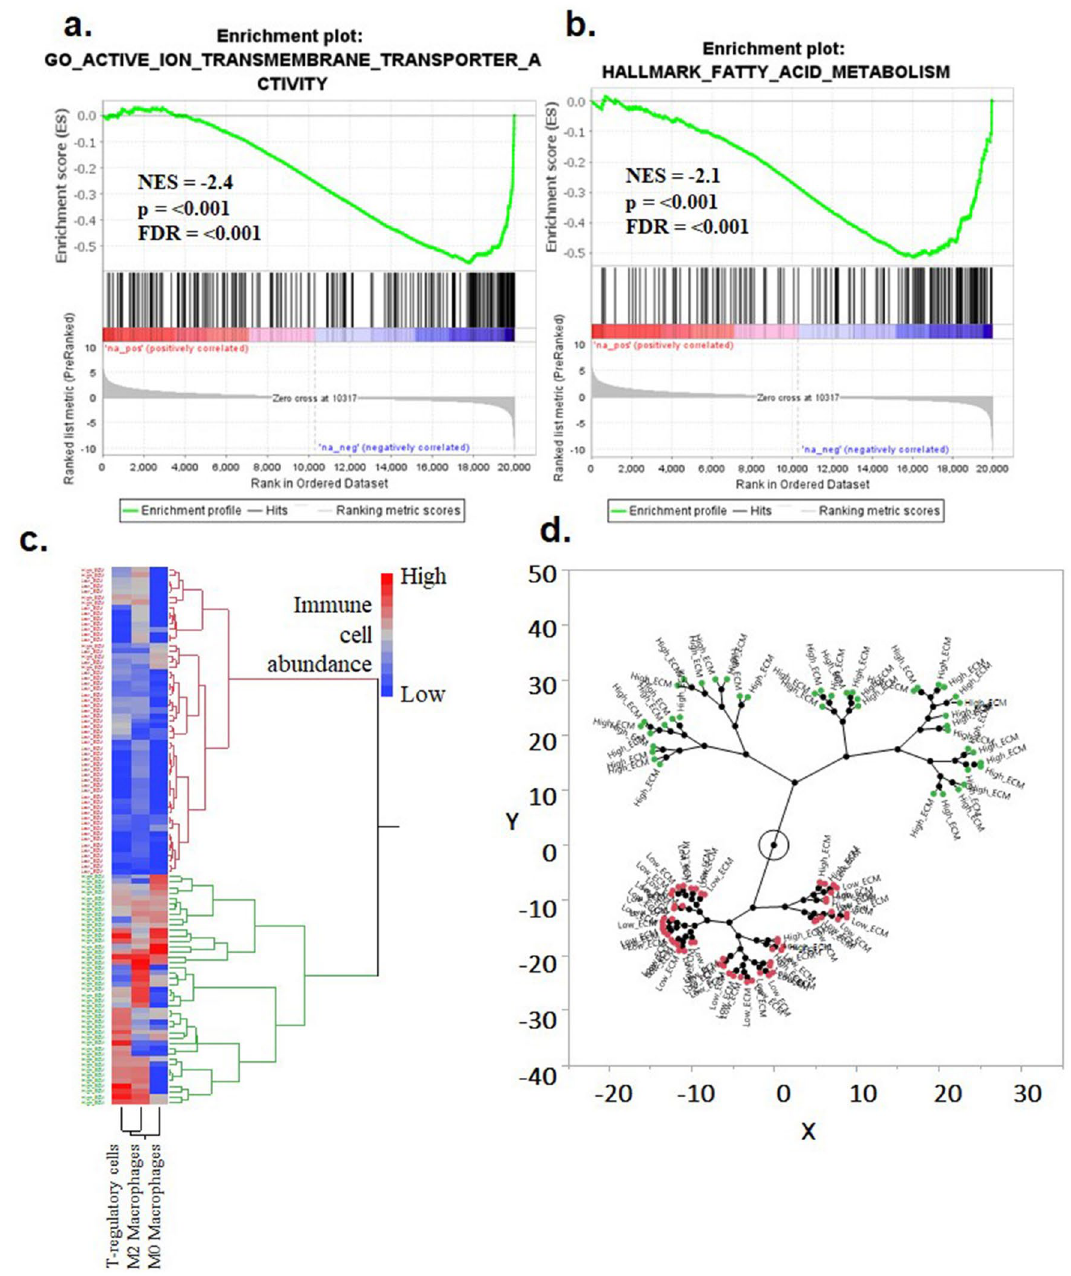
Figure 7. GSEA analysis of the differentially expressed genes between the two risk groups. ( a ) Pathways enriched in the low-risk group were ( b ). Active ion transmembrane transporter and ( b ). Hallmark of fatty acid metabolism. ( c ) Hierarchical tree structure and ( d ) constellation plot classifying the high-risk patients according to correlation with tumor-promoting immune cell